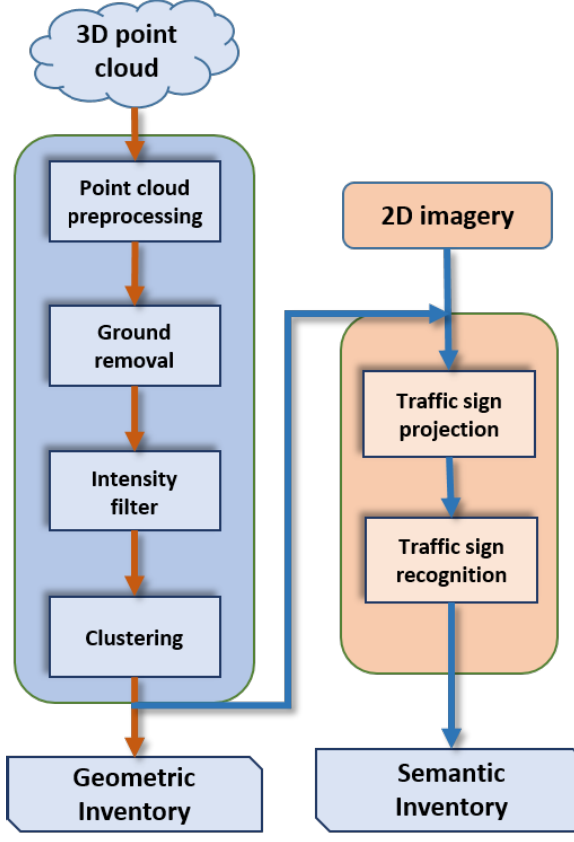
Figure 1. Flowchart which describes the proposed